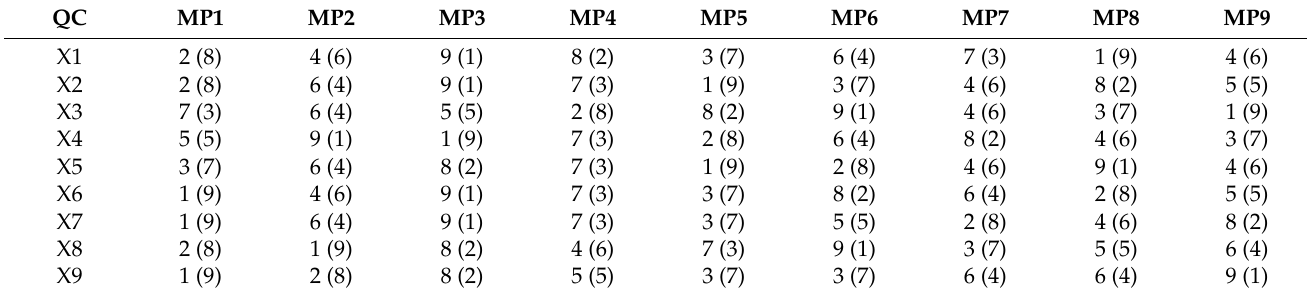
Table 8. BO (OW) pairwise comparisons of experimental responses.